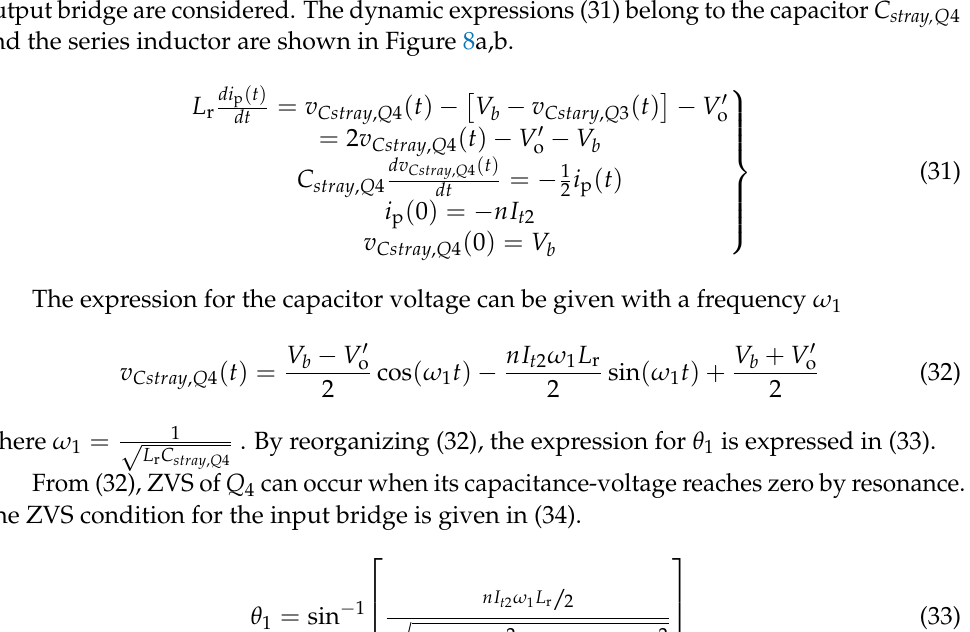
Figure 8. Equivalent circuits with the stray capacitance of the switches ( a ) input bridge and ( b ) output bridge in forward mode ( c ) output bridge ( d ) input bridge during the reverse mode of operation. The bridges are symmetrical, so events belonging to Q 4 on the input and Q 7 on